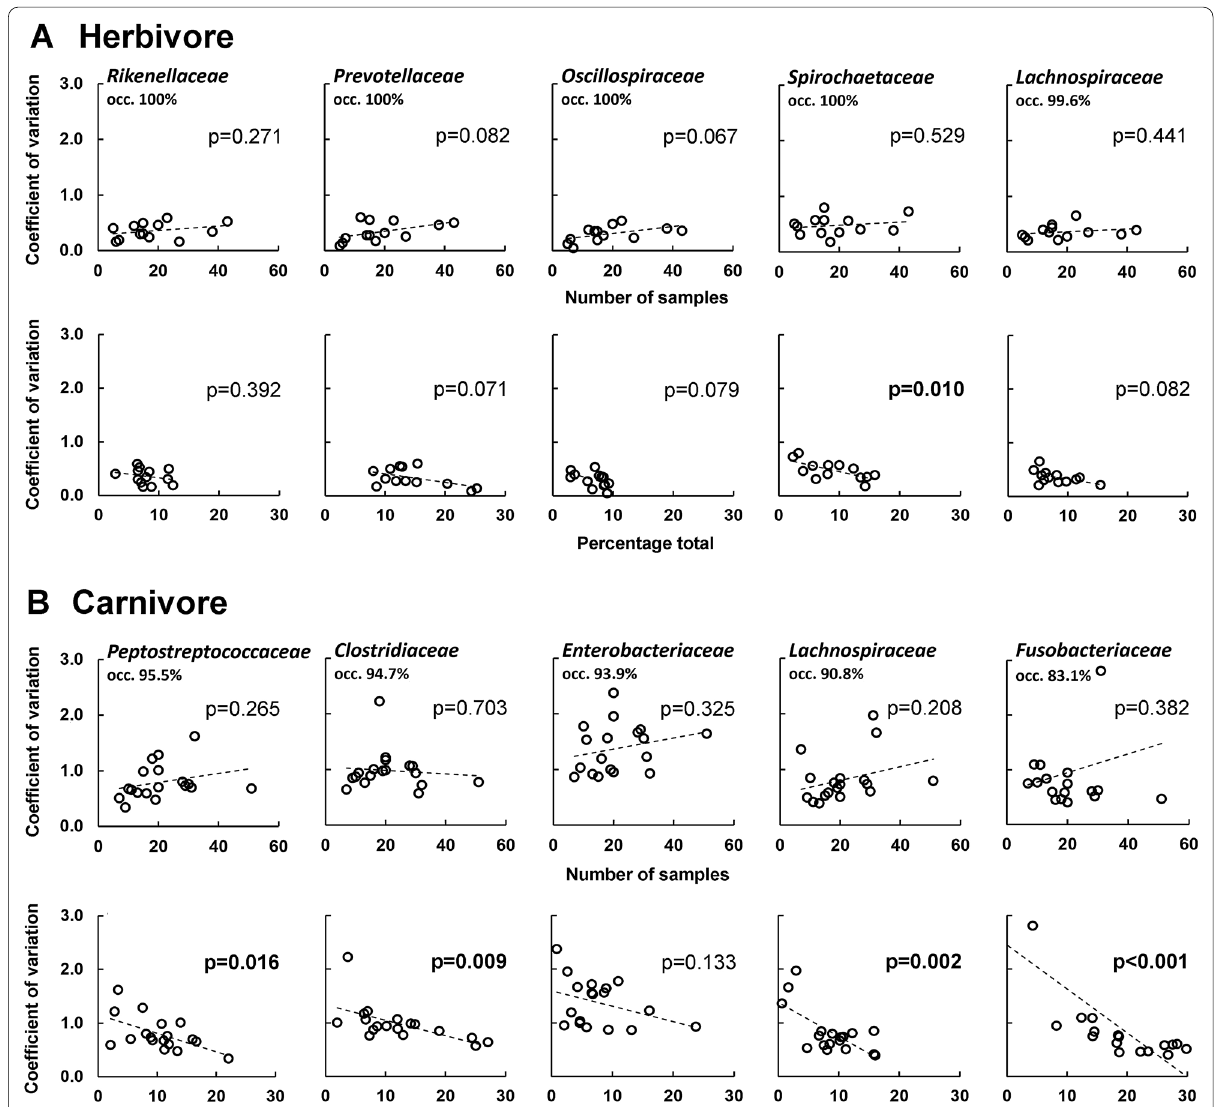
Fig. 4 Coefficient of variation of different bacterial families for all herbivores ( A ) and carnivores ( B ) plotted against the number of samples (top row in each case) and against the total percentage of occurrence averaged per species (bottom row in each case). The tendency is indicated by a linear regression line and significant p -values are indicated in bold. The occurrence in the total sample is given for each bacterial